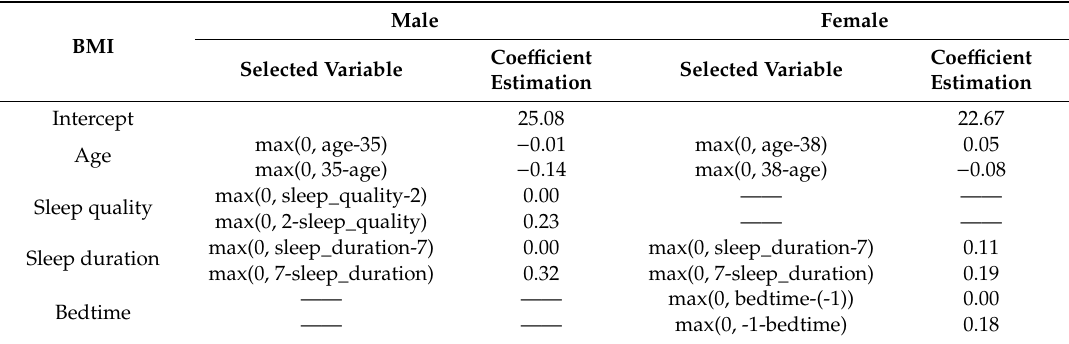
Table 4. Estimation results for BMI by gender.